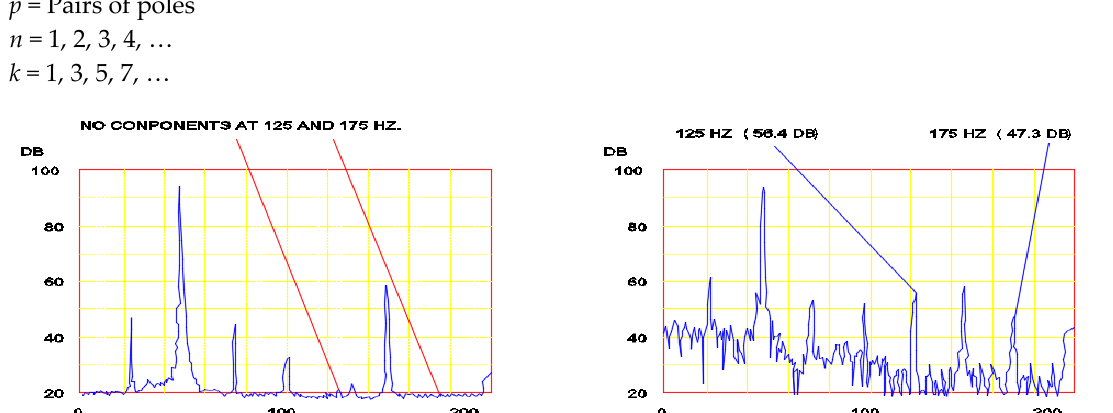
Figure 10. Spectrum FFT of the current signal of a motor with 20% burnt turns, as shown in [33]. Reproduced with permission from IEEE,